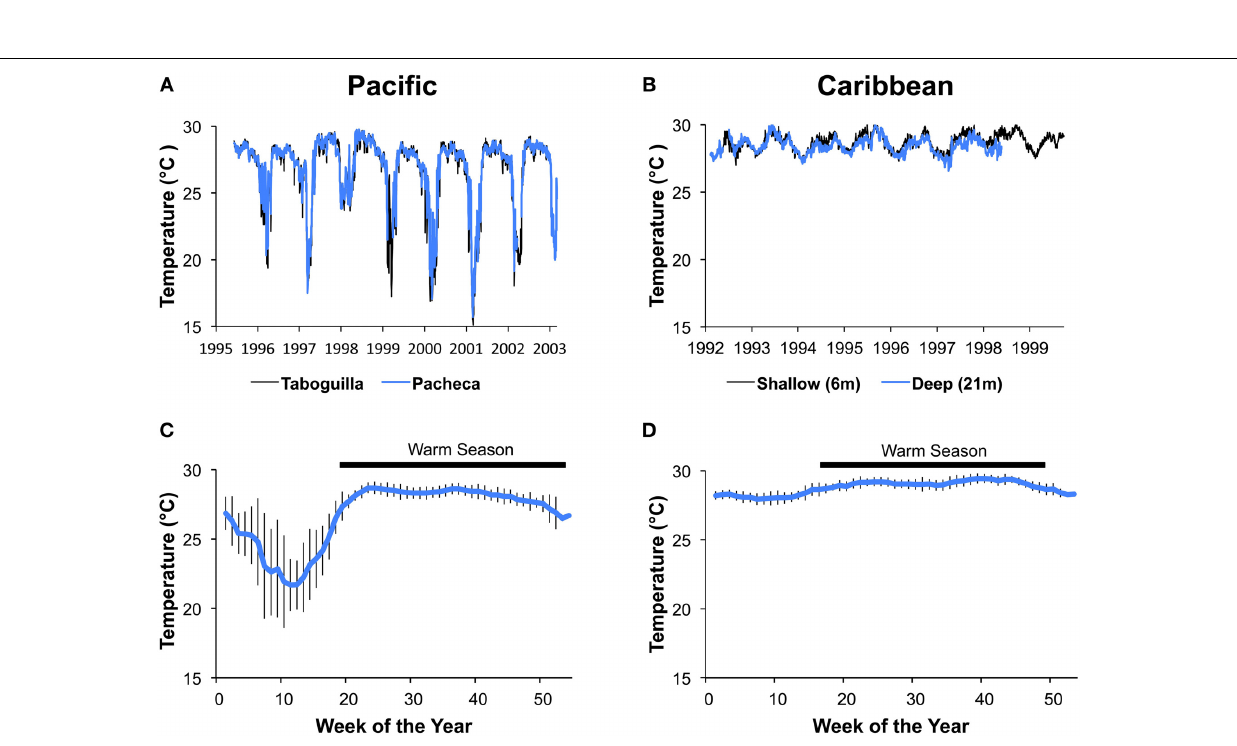
week show a colder and more variable temperatures during upwelling the Pacific depicted with data from Pacheca island (C) compared to the more stable Caribbean depicted with data from the shallow site at Punta de San Blas (D) . Vertical lines show standard deviations of the